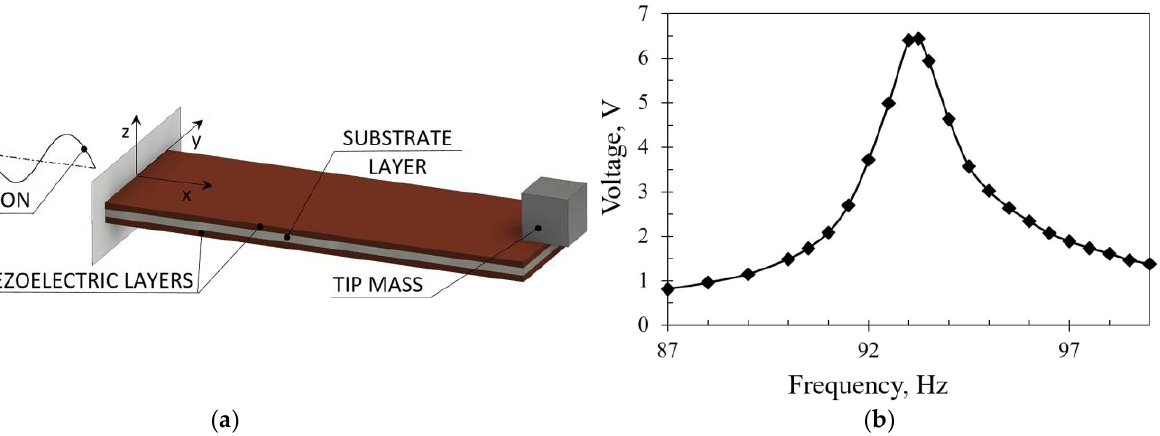
Figure 1. Bimorph PEH with a tip mass: graphical representation ( a ) and typical response when subjected to harmonic excitation ( b ) [2].